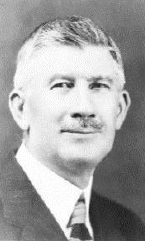
Fig. 3. George Ashley Campbell. July 17,